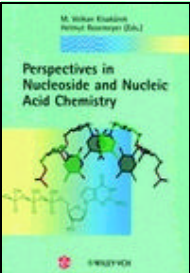
NUCLEOSIDES AND